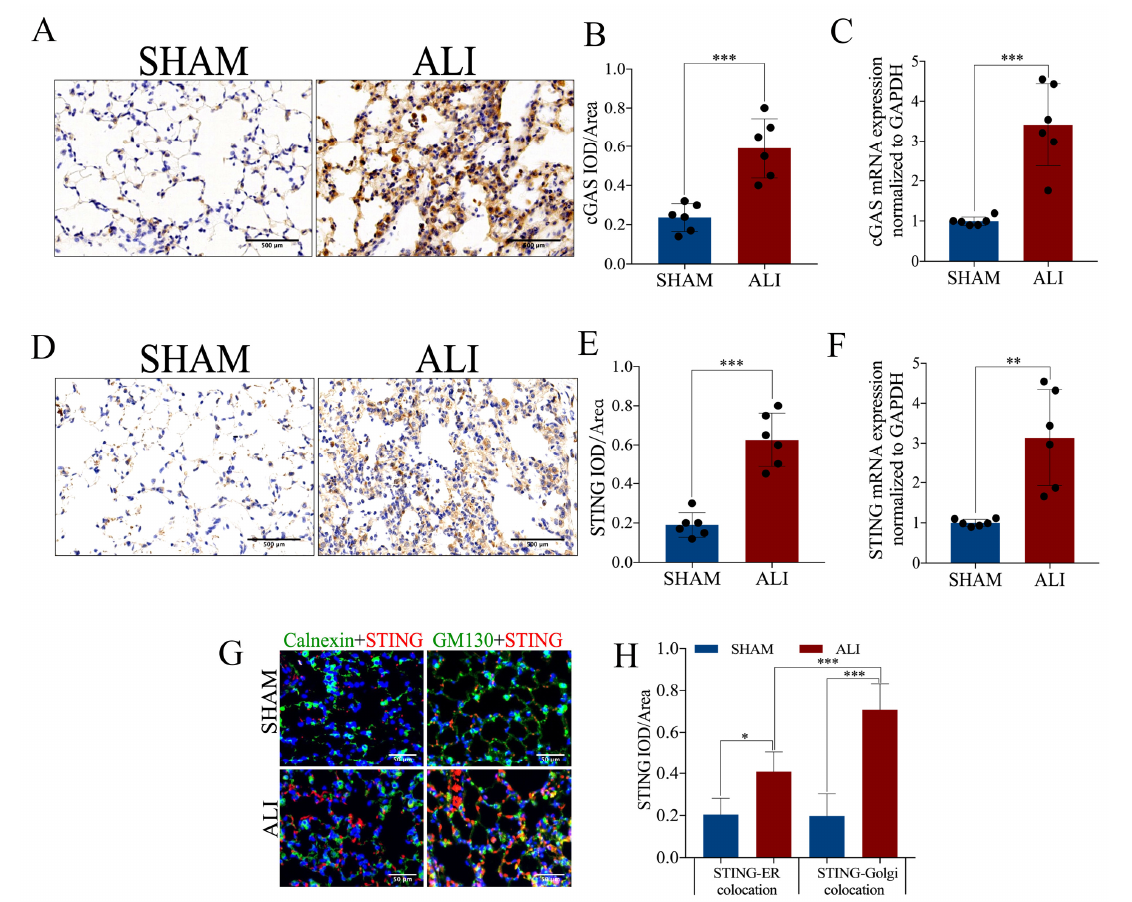
Figure 4. cGAS-STING expression is up-regulated in LPS-induced acute lung injury. ( A ) Representative images of immunohistochemical staining of cGAS (scale bar = 500 µm). ( B ) Statistics of the positive signal of cGAS in lung tissue. ( C ) cGAS mRNA expression in lung tissue. ( D ) Representative images of immunohistochemical staining of STING (scale bar = 500 µm). ( E ) Statistics of the positive signal of STING in lung tissue. ( F ) STING mRNA expression in lung tissue. ( G ) Representative images of immunofluorescence co-localization of calnexin (green) and STING (red), and GM130 (green) and STING (red) (scale bar = 50µm). ( H ) Fluorescence signal statistics of cGAS and STING located in the ER and Golgi. IOD = integral optical density. Data are presented as the mean ± SD, n = 6 per group. * p < 0.05, ** p < 0.01, *** p < 0.001. Comparisons between two groups were analyzed by an unpaired t test.